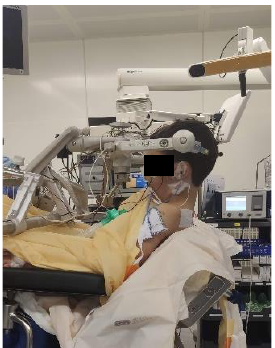
Figure 4. Sitting positioning [12] (Pictures reprinted/adapted with permission from Jehuda Soleman, MD).